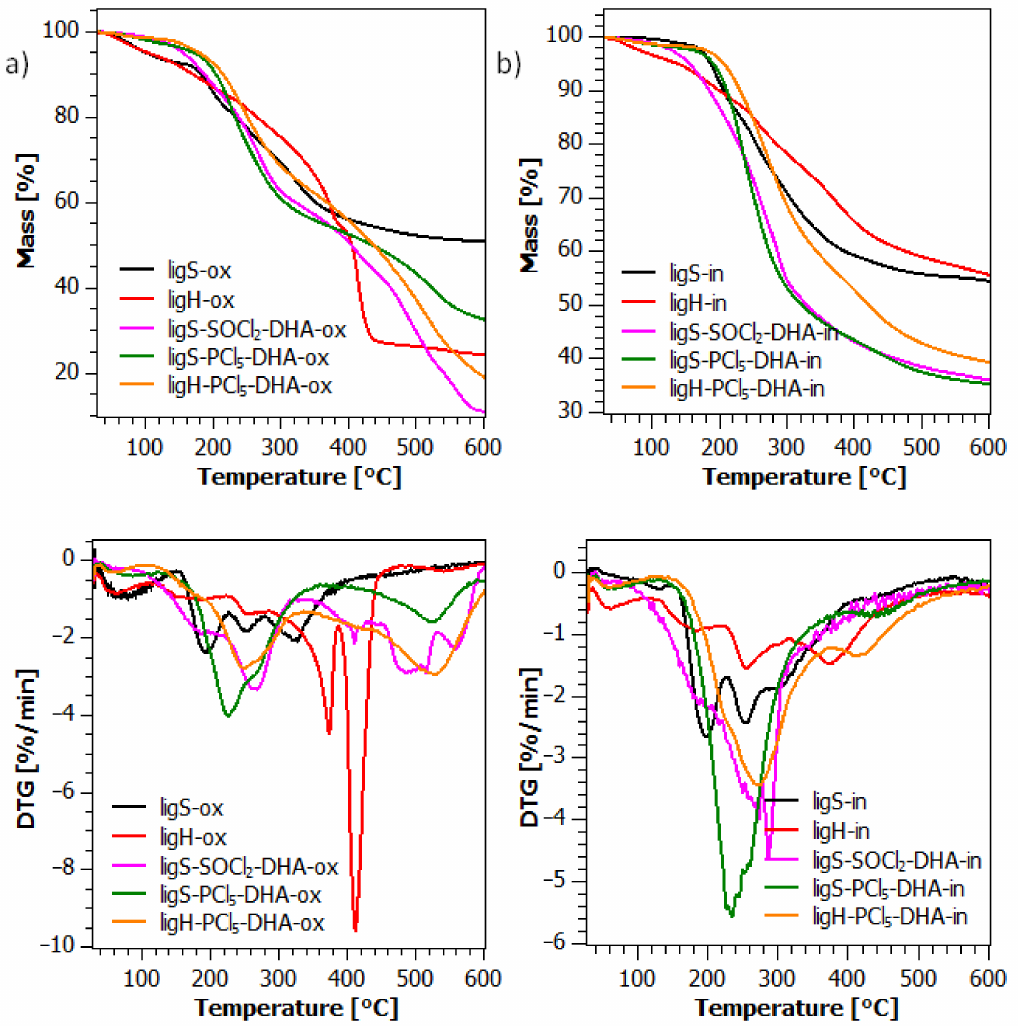
Figure 8. TG and DTG curves of the materials after the second step of modification during thermo- oxidative ( a ) and pyrolytic ( b )